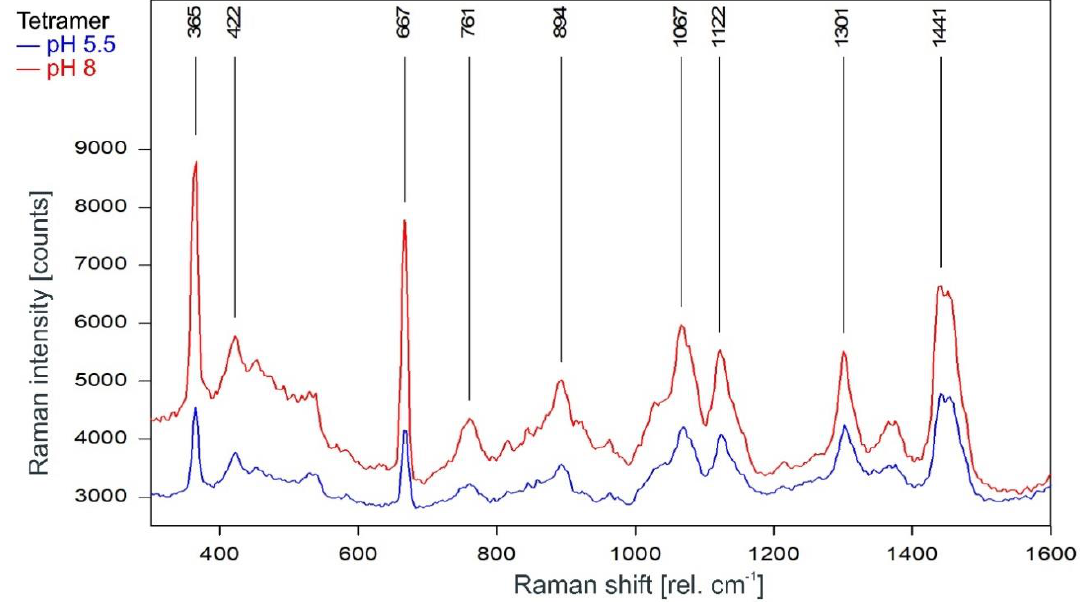
Figure 3. Raman spectrum of the KcsA channel tetramer between 300 and 1600 rel. cm − 1 in its open state at pH 5.5 (blue) and its closed state at pH 8 (red) as recorded. Raman lines shared by the spectra are marked in black.